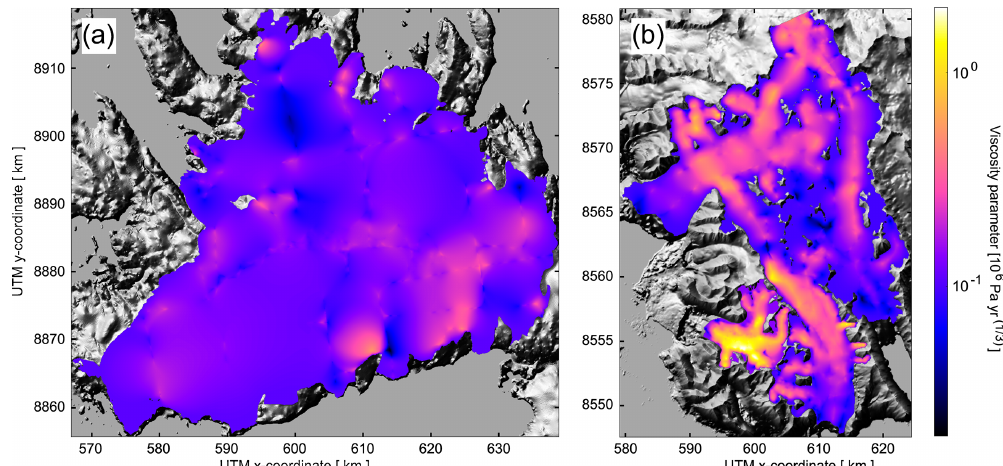
Figure A1. The ice-viscosity parameter B for VIC (a) , THPB and WSB (b) is inferred during the first step of the reconstruction as explained in Sect. 2.2.4. This parameter is used to match observed and reconstructed thickness values. An interpretation in terms of material property is delicate because the parameter compensates for input uncertainties and inconsistencies as well as for assumptions in the first-step recon- struction. Background: grey-scale hill-shaded topography based on a NPI 50m DEM (http://publicdatasets.data.npolar.no/kartdata/NP_S0_